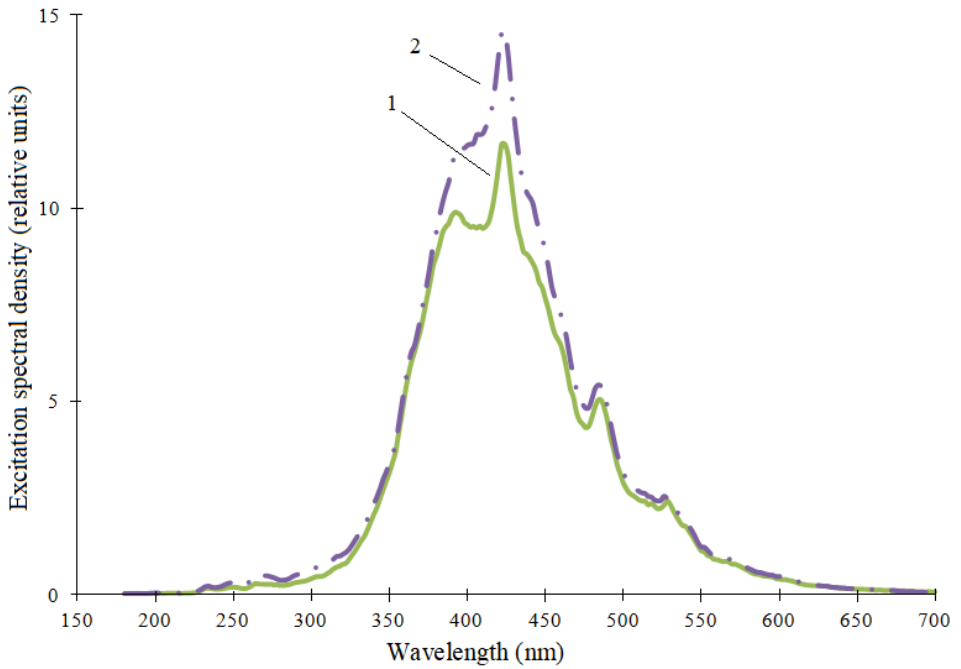
Figure 1. Excitation spectra of oat seeds during synchronous scanning: 1—uninfected, 2—infected by 82.4%.